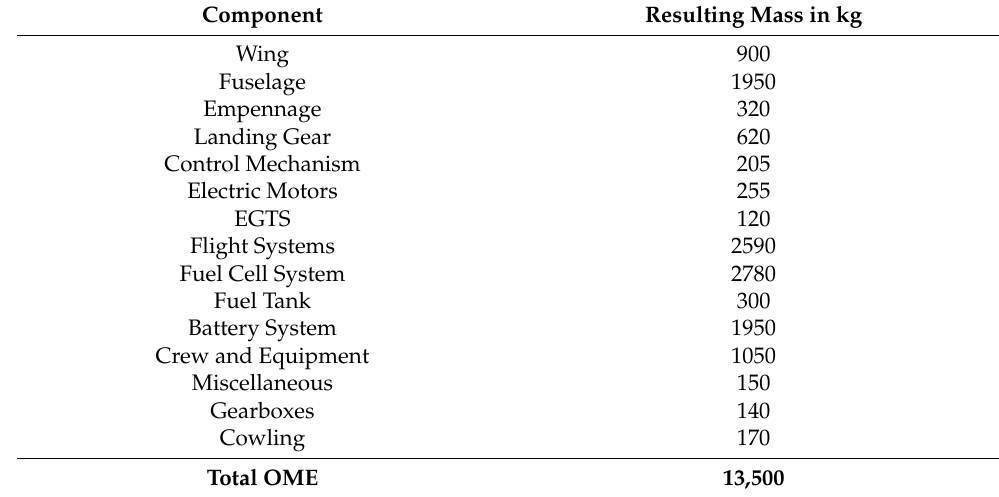
Table 12. Summary of the component